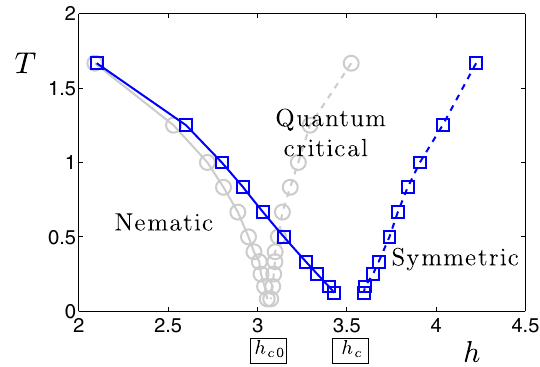
FIG. 1. Phase diagram of the model obtained by DQMC simulations, as a function of the transverse field h and temper- ature T . Here, the other parameters entering the Hamiltonian Eq. (3) are V ¼ t , α ¼ 0 . 5 , μ ¼ − 0 . 5 t . The solid line marks the transition temperature T between the nematic and the symmetric N phases. The line extrapolates to the T ¼ 0 QCP at h . The dashed c line marks T , where the nematic susceptibility reaches 50% of cross ≈ 3 . 525 at the same temperature. The its magnitude at h ¼ h c gray lines show the corresponding temperatures for the case α ¼ 0 (where the fermions and pseudospins are decoupled). In ≈ 3 . 06 . this case, the QCP occurs at h c 0